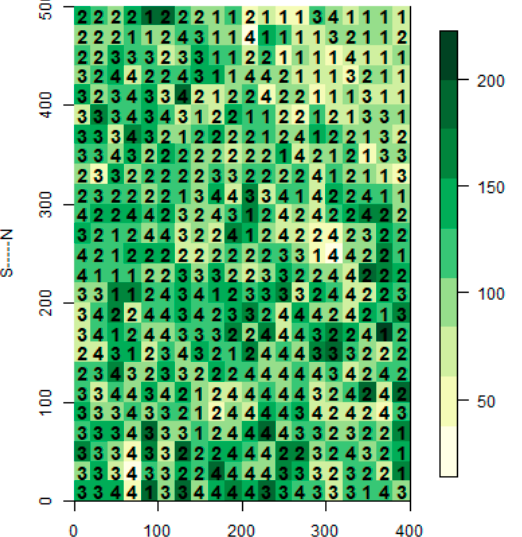
Figure 2. Biomass (Mg/ha) for each grid cell, with habitat type identified through hierarchical cluster analysis (1: Steep slope; 2: Valley; 3: Ridge; 4: Gentle slope).